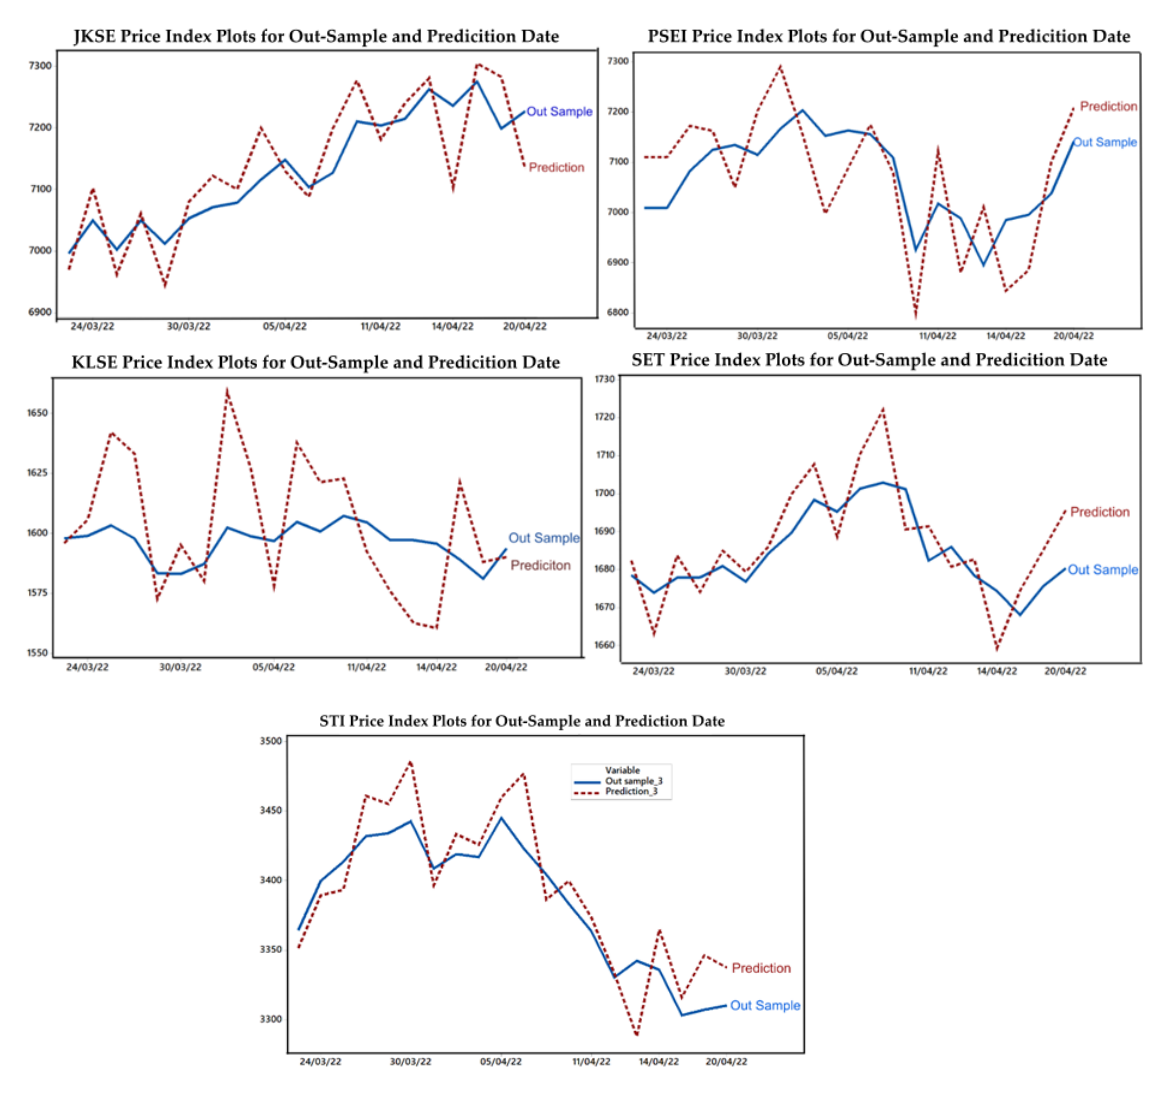
Figure 3. Out-sample stock price index comparison plots and predictions.